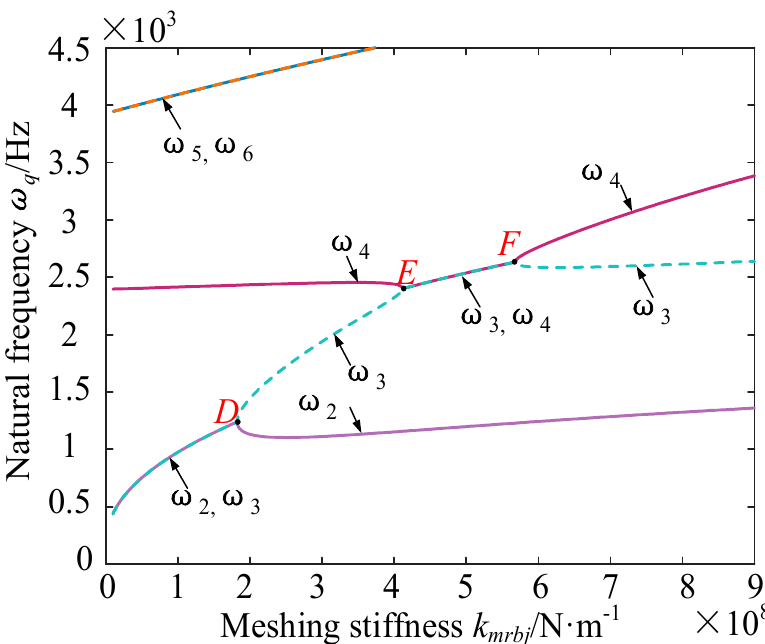
Figure 8. The trajectory of the natural frequency with k mraj .